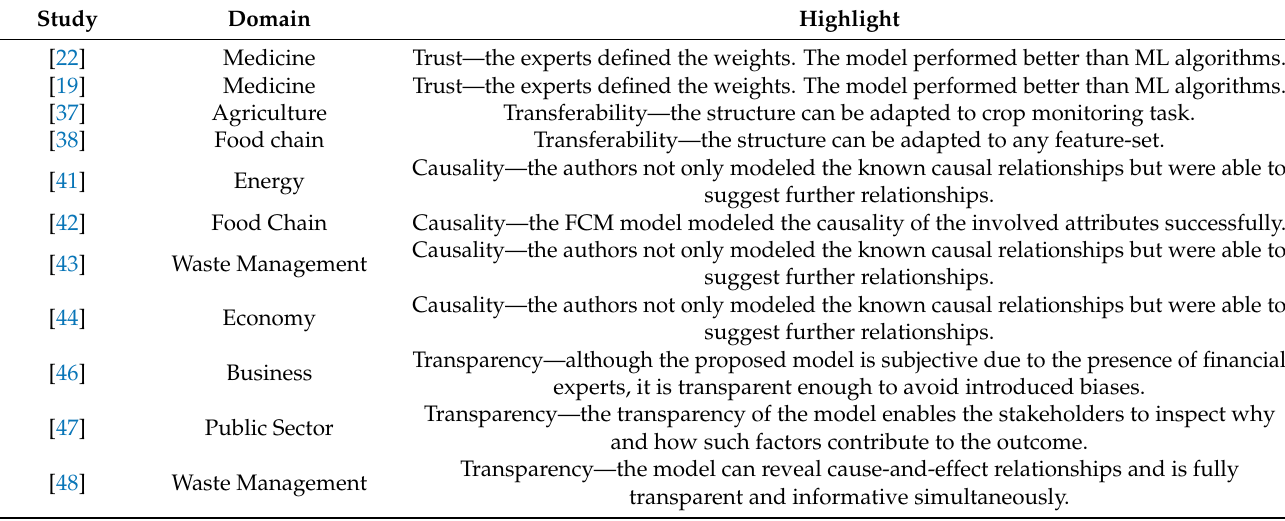
Table 5. Summary of FCM models and their